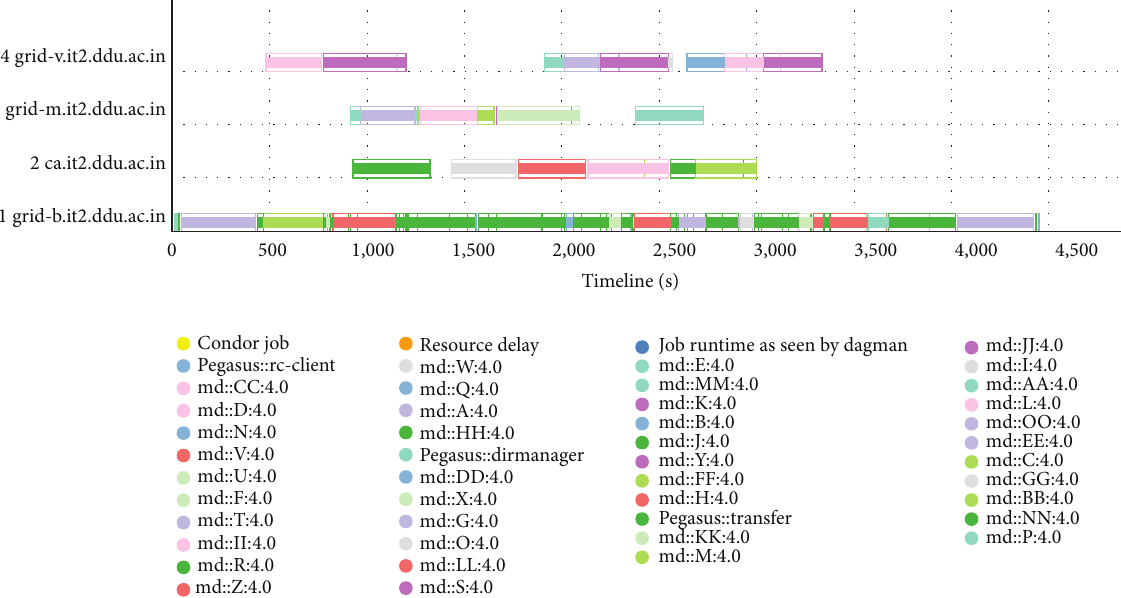
Figure 5: Output schedule for the workflow of 41 tasks with small data communication scheduled using LHIPWF site-selector proposed and implemented by us.